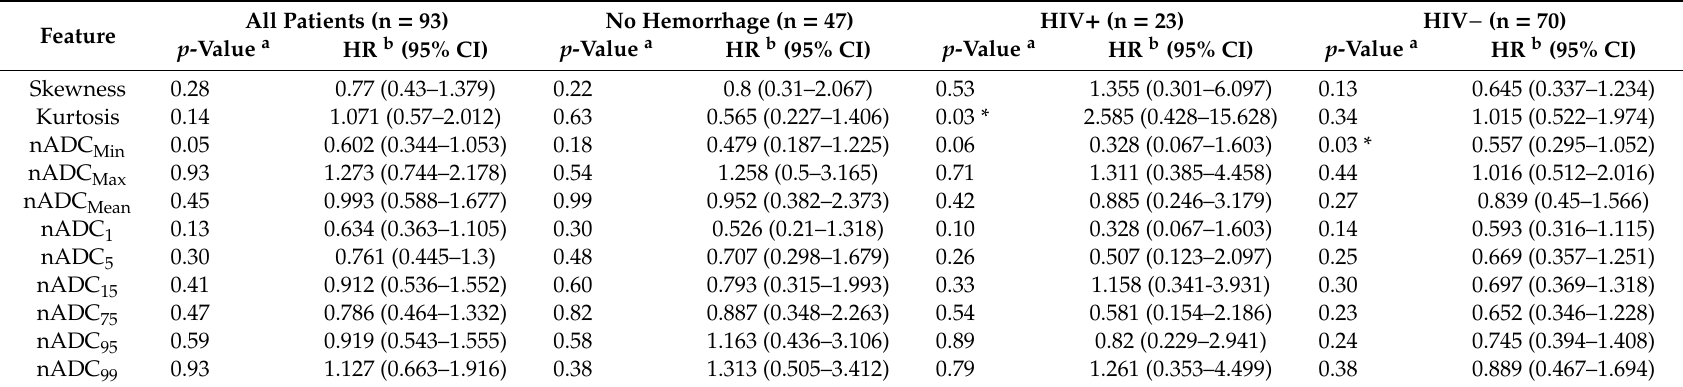
Table 5. Hazard ratios for progression-free survival in all patients and patients without lesion hemorrhage. Results are considered significant (*) when p <